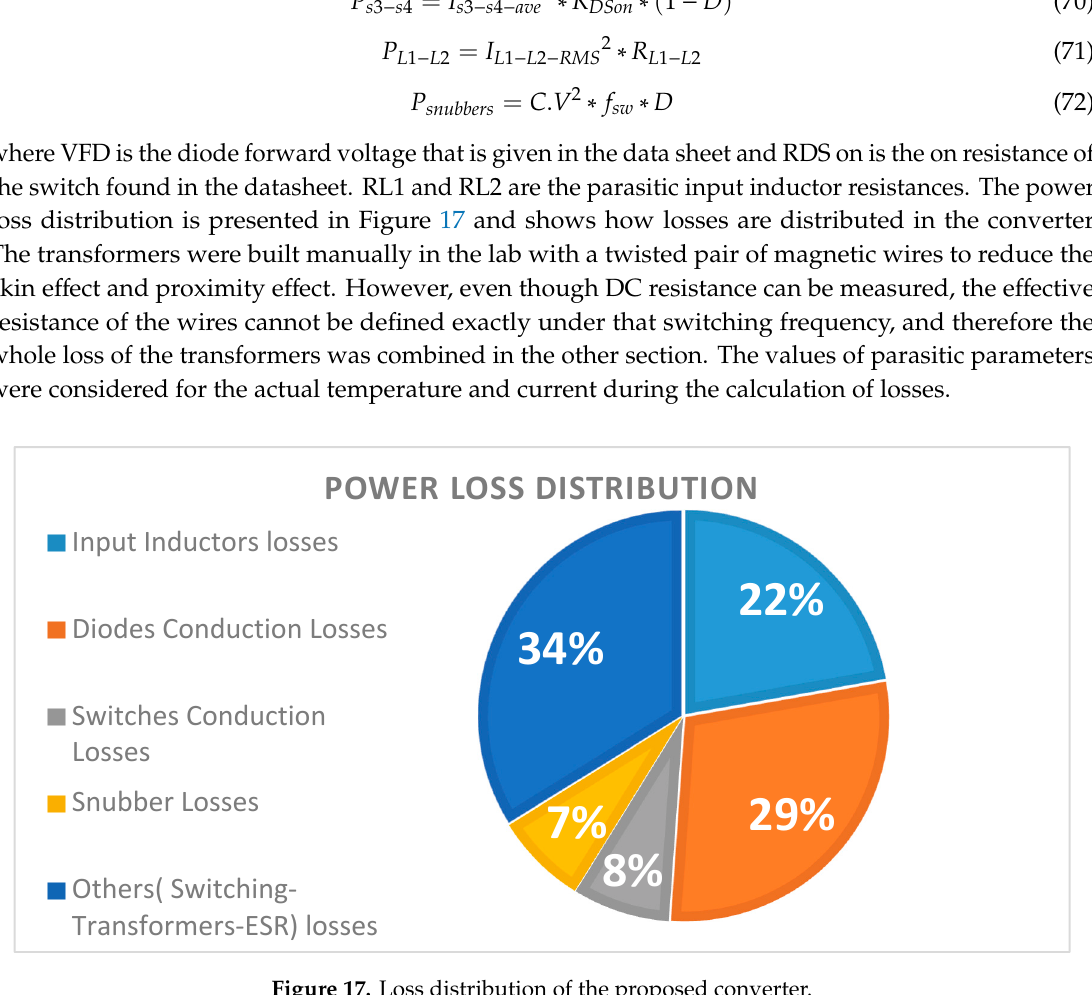
Figure 17. Loss distribution of the proposed converter.